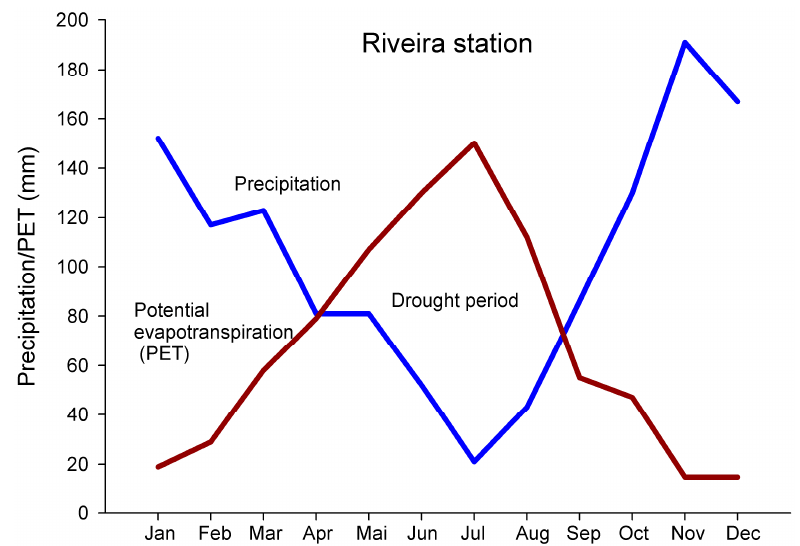
Figure A1. Diagram of precipitation / PET (mm) measured at the Riveira meteorological station, located Figure 1. Diagram of precipitation/PET (mm) measured at the Riveira meteorological station, located near the study near the study areas.